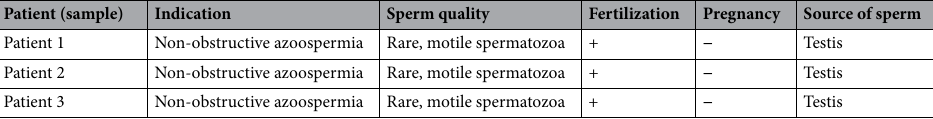
Table 1. Characteristics of men included in the program of sperm quality and in vitro fertilization providing sperm samples